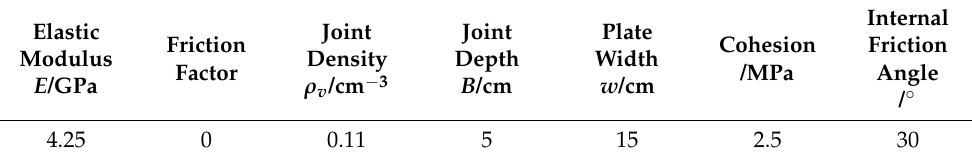
Figure 3. Mechanical Model of a Fractured Rock Mass. Table 2. Parameters for Calculation